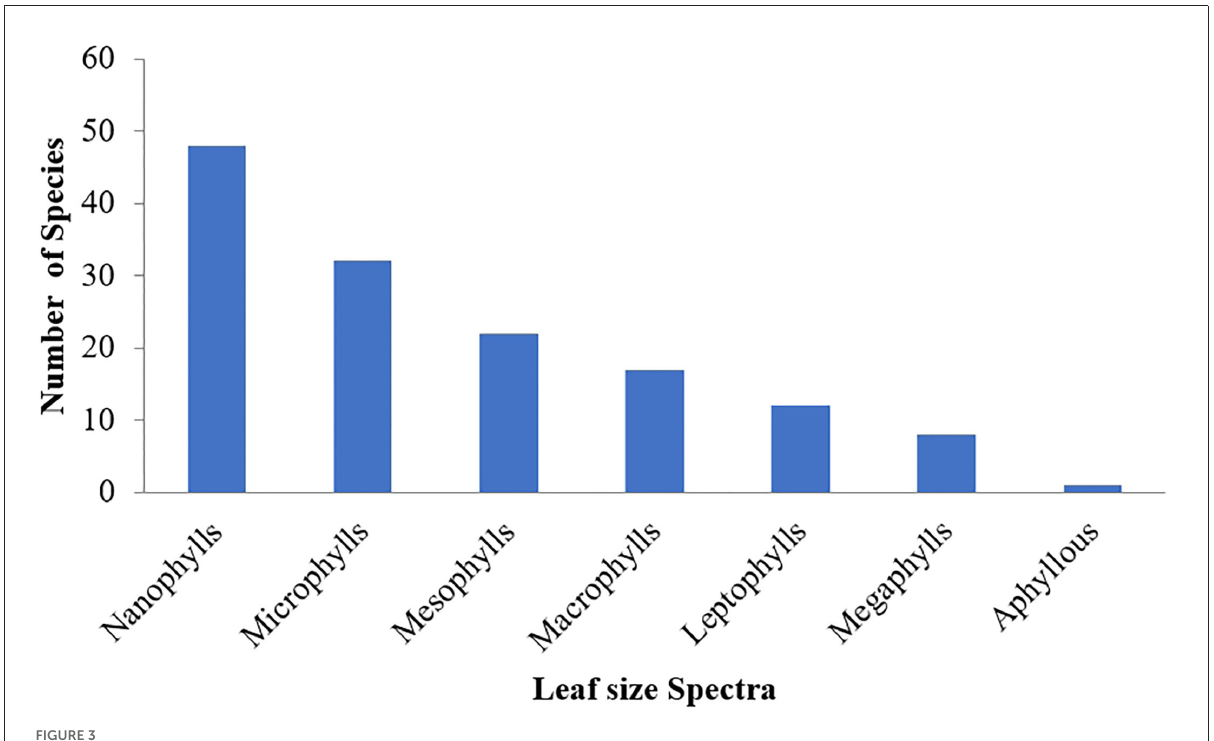
FIGURE3 Leaf size spectrum in Bin Dara, western boundary of